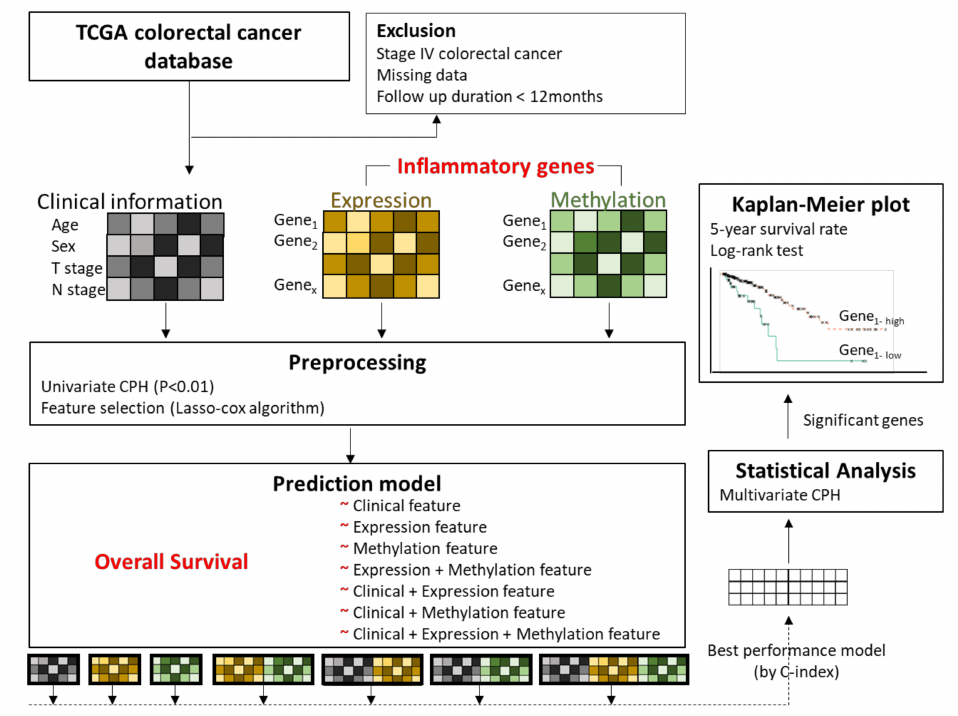
Figure 1. Overview of the analysis framework. We preprocessed the gene sets related to inflammatory status and clinical information, based on the significance of association with overall survival by performing univariate Cox proportional hazard regression (CPH) analysis. These features passed the suggestive significance level ( p < 0.01). Features with concatenated expression and methylation were also included. Feature selection was performed by using Lasso-penalized Cox proportional hazards regression (Lasso-Cox). Seven modes were designed by respective combinations of features, and the performances were evaluated by Lasso-Cox according to the C-index. Among the models, the highest C-index model was used for multivariate CPH analysis of overall survival. Then, Kaplan–Meier analysis was performed for the genes that were significantly associated with overall survival, and the log rank test was performed for comparisons of each